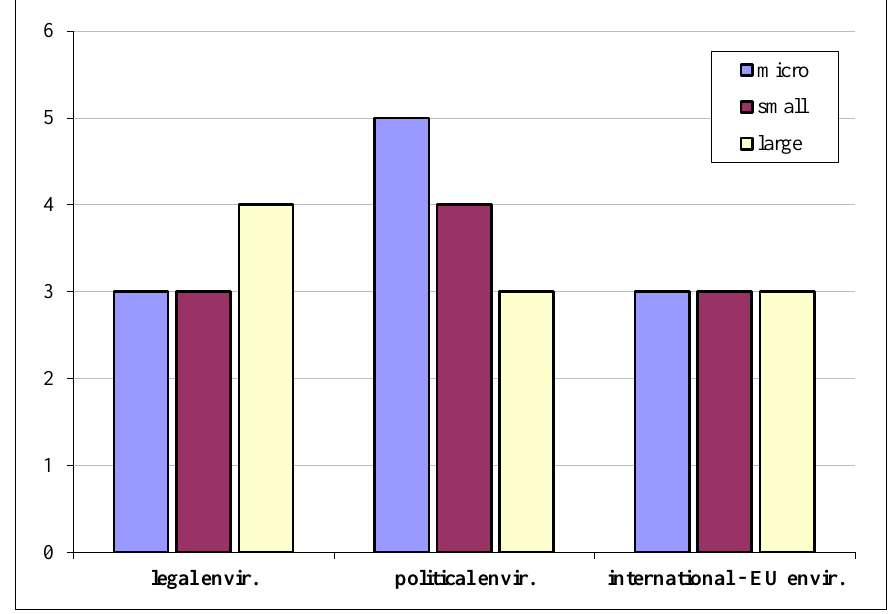
Figure 7. Intensity of legislative and political